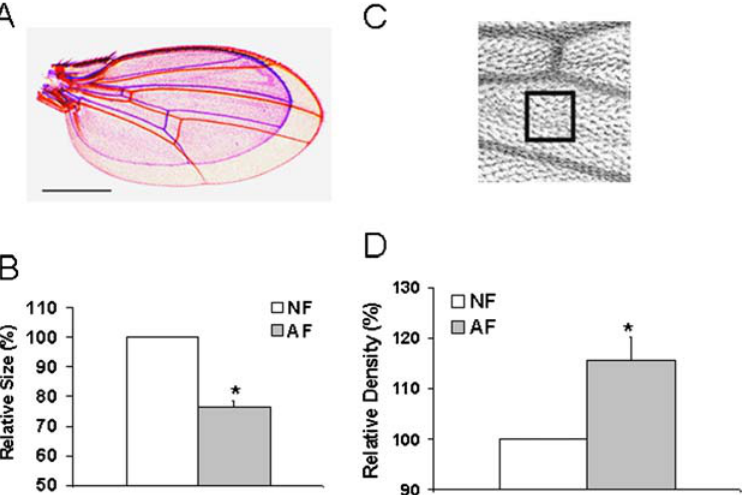
Figure 2. Decreased cell number and size in AF flies. The wing was used as a model organ to determine whether the weight and size reduction in AF flies could be due to either a reduction in cell number, a reduction in cell size (i.e. increase in cell density) or both. Panel A is representative pictures of wings from an AF (blue) and a NF (red) fly (bar=250 m m). There was more than 20% reduction in wing area in AF (B; n=16, p , 0.01), that is not able to be fully compensated by a corresponding increase in cell density (C and D; n=16, p , 0.01). Further estimation of the total number of cells in the wing by multiplying the area by the cell density resulted in a total 10.2% cell loss in AF flies. Therefore, the reduction of the fly size is due to decrease of both cell size and cell number. Data were presented as mean 6 SEM. The statistical significance was calculated by student’s t